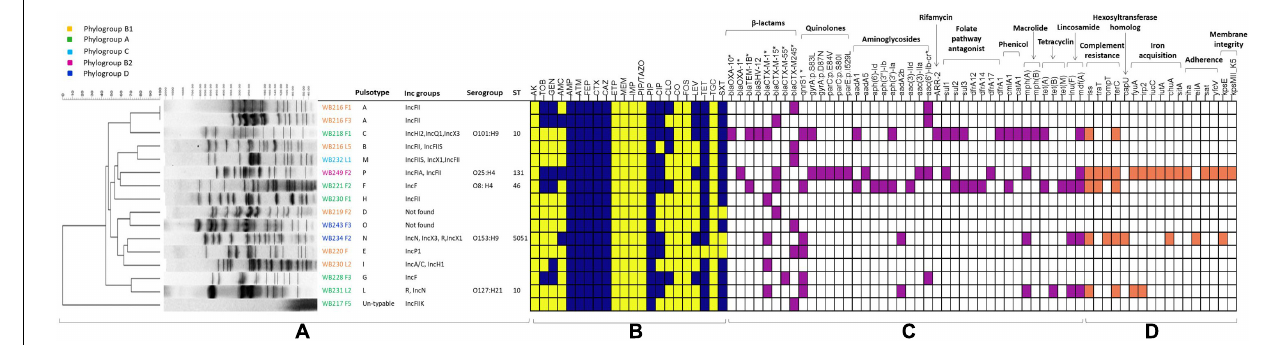
FIGURE 1 | The figure includes all the phenotypical and molecular characterisation, including the analysis performed with whole-genome sequencing (WGS). The part (A) is related to the molecular typing by pulsed-field gel electrophoresis (PFGE), with the identification of pulsotypes, phylogroups, and plasmid replicons, for all the extended-spectrum beta-lactamase (ES β L)-producing Escherichia coli strains, while STs and serogroups are evidenced for the sequenced strains. The heat map (B) shows the phenotypical resistance profile of all ES β L-producing E. coli , where yellow identifies susceptible phenotype, while blue identifies the resistance phenotype. The molecular determinants found by PCR and genome analysis are evidenced in the heat map in purple (C) , while the virulence genes harboured by the sequenced strains are shown in orange (D) . AMR genes and virulence factors are grouped by evidenced categories. AMC, amoxicillin/clavulanic acid; AMP, ampicillin; PIP, piperacillin; ATM, aztreonam; FEP, cefepime; CTX, cefotaxime; CAZ, ceftazidime; CXM, cefuroxime; CIP, ciprofloxacin; LEV, levofloxacin; TZP, piperacillin-tazobactam, AK, Amikacin; GM, gentamicin; TOB, tobramycin; CLO, chloramphenicol; ERT, ertapenem; IMI, imipenem; MEM, meropenem;